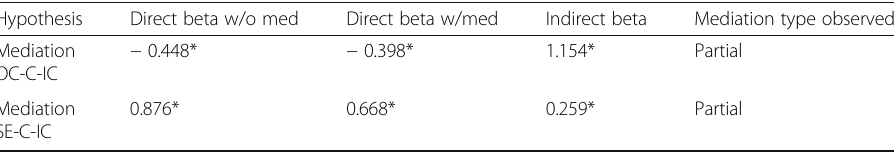
Table 4 Mediation results Hypothesis Direct beta w/o